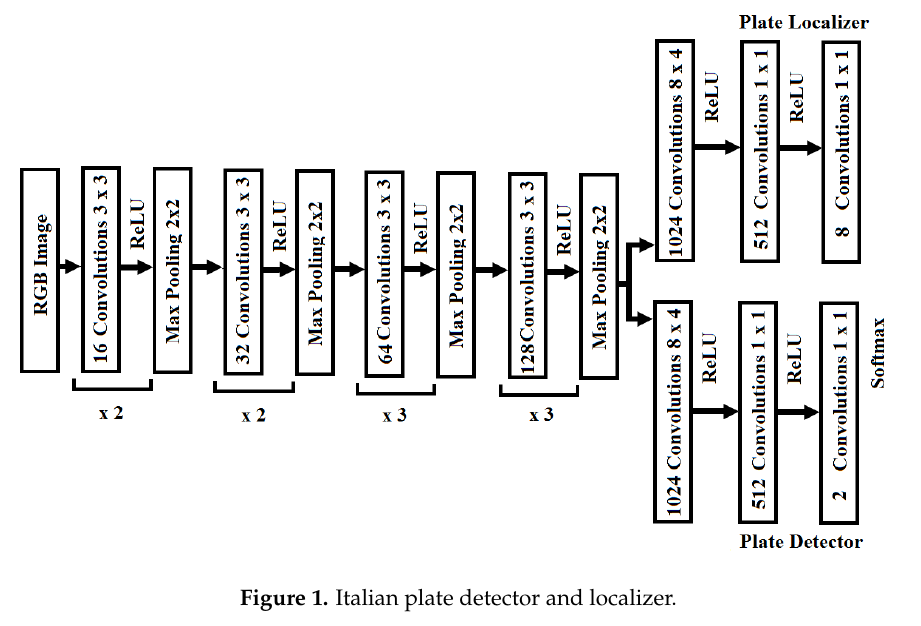
Figure 1. Italian plate detector and localizer.